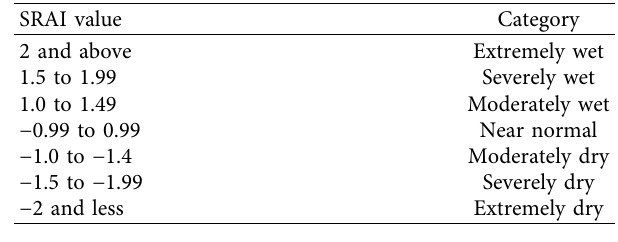
Table 2: Standardized rainfall anomaly index (SRAI) value and classes